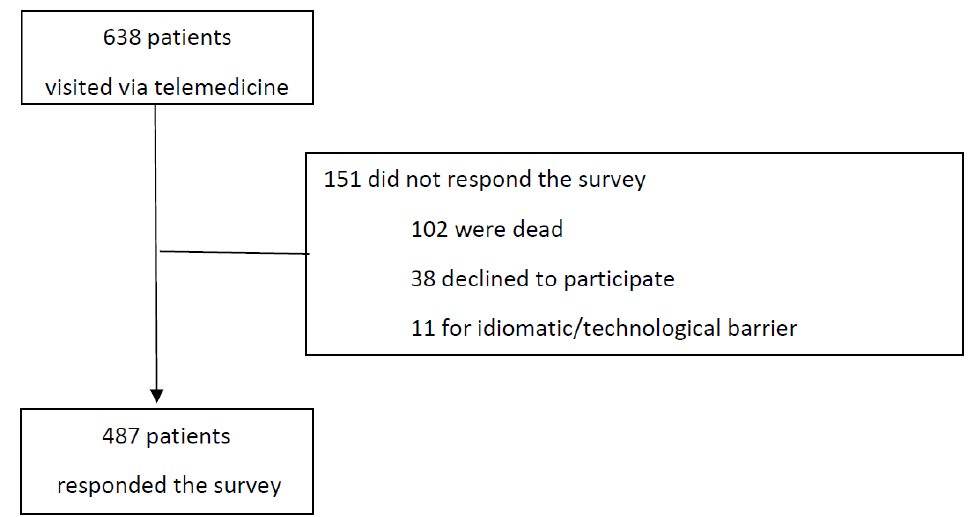
Figure 1. Patients’ flowchart. In total, 638 patients were visited via telemedicine, and 487 answered the survey.